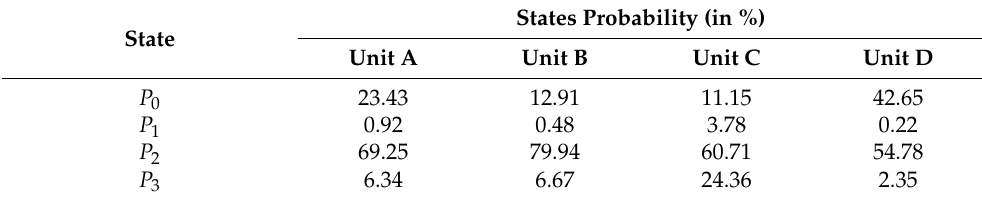
Table 3. Four-state probability model for FPSO generators—Scenario 1.